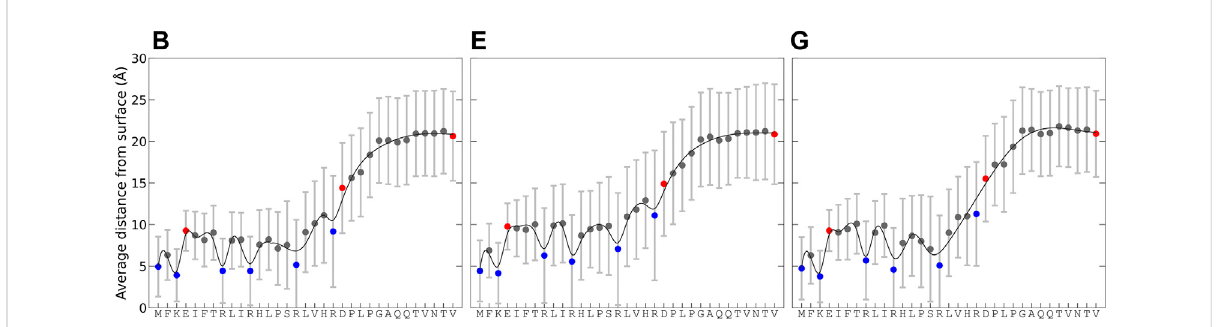
Average distance from the Laponite ® surface for each residue and its standard deviation, calculated from the change in minimum distance between each pair over time for the concatenated trajectory of the replicates. For the force fi eld and water combinations B, E, and G. Charge of residues indicated with the colors: blue (positive), red (negative), and gray (neutral). Lines are included as a “ guide to the eye.